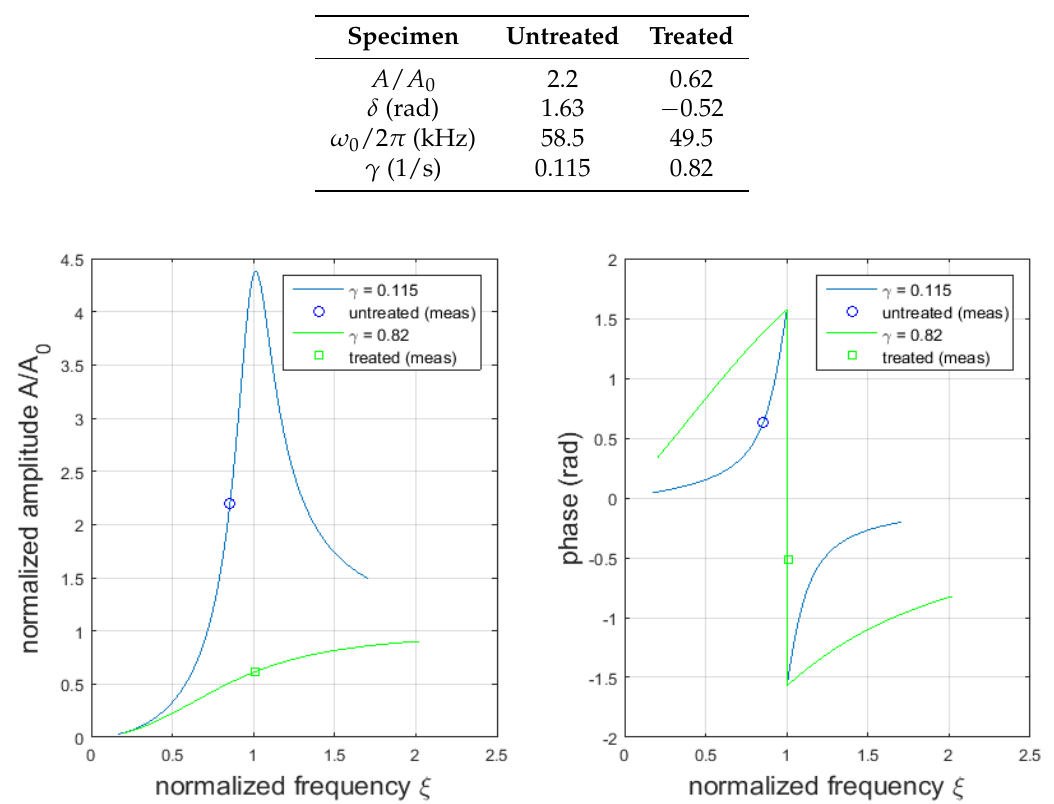
Figure 6. Assimilation of observed relative amplitude and phase with harmonic response function Equations (10) and